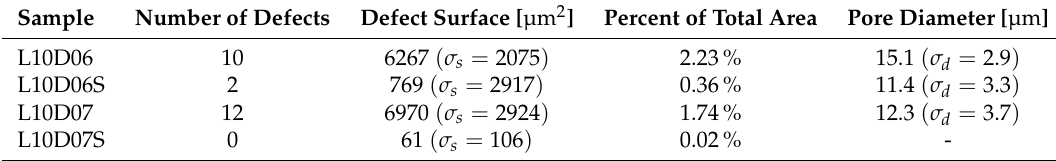
Table 4. Mean properties of pores, visible on the fracture surfaces of the test